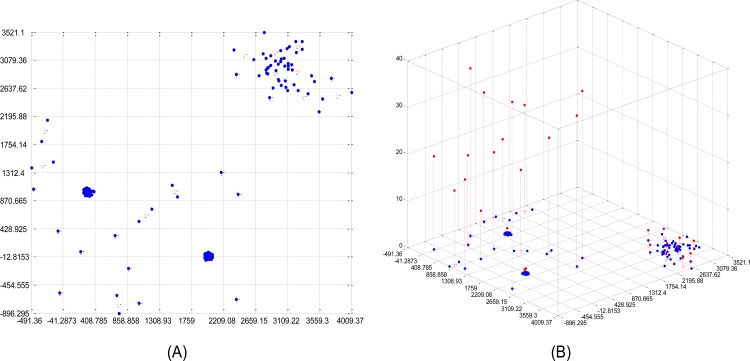
Grid-LOF values of the dataset in Fig 1.(A) Grid centroids (k = 10). (B) LOF values of Grid centroids.